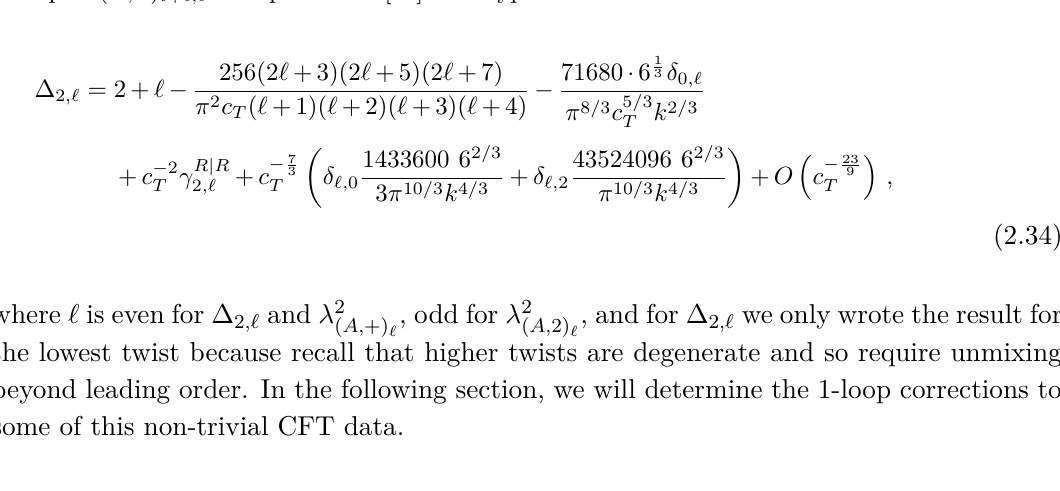
Table 2 . Contributions from large s, t degree a contact Mellin amplitudes M a ( s, t ) to the OPE coefficients squared λ 2 of some protected multiplets ( B, +) , ( B, 2) , ( A, +) ‘ for even ‘ , and ( A, 2) ‘ 22 M for odd ‘ , as well as to the anomalous dimensions γ t,‘ for even ‘ of the lowest twist t = 2 unprotected multiplet ( A, 0) t + ‘,‘ . Adapted from [10] with typos